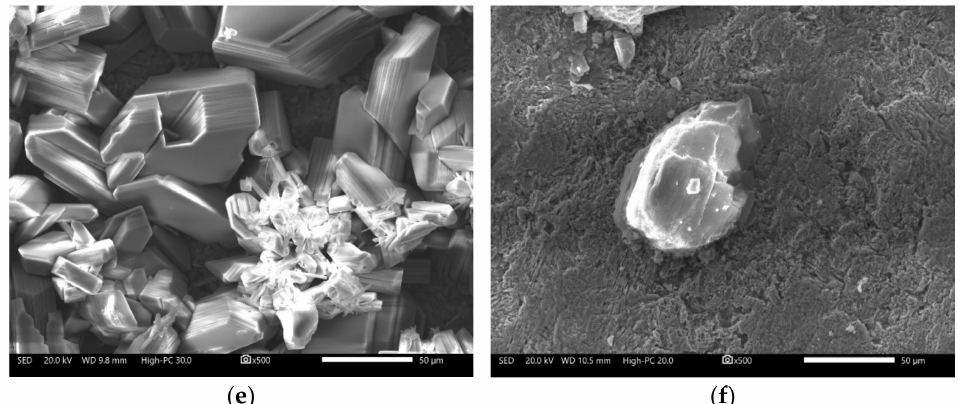
Figure 10. The morphological aspect of 1018 carbon steel after corrosion test in CO 2 -saturated brine solution at different concentrations of the added inhibitor. 0.1 mM; ( a ) corrosion products surface; ( b ) clean surface. 1.0 mM; ( c ) corrosion products surface; ( d ) clean surface. 10.0 mM; ( e ) corrosion products surface; ( f ) clean surface.